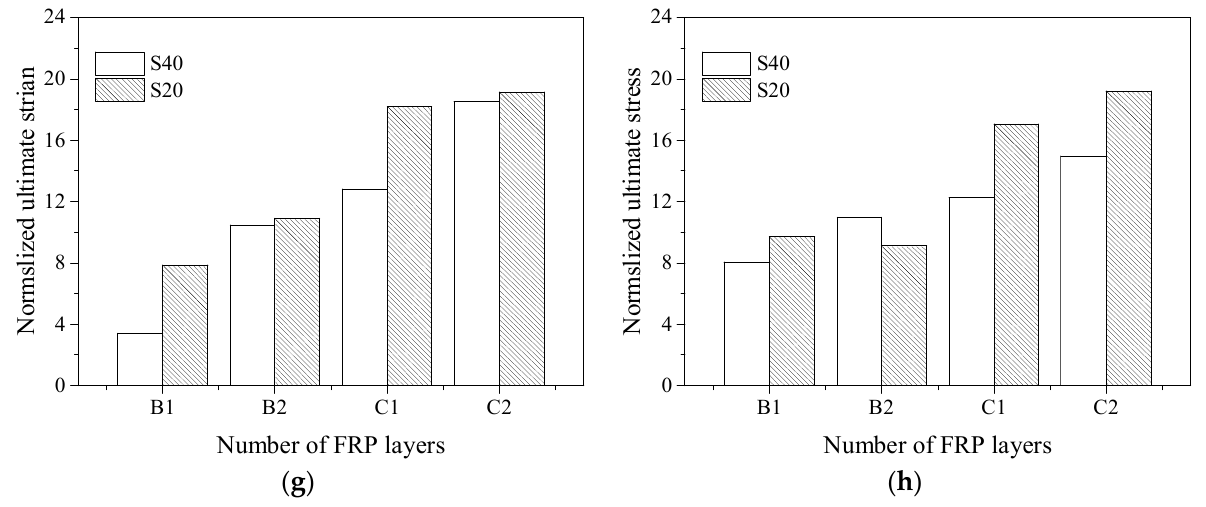
Figure 9. Effect of the stirrup spacing on the compressive behaviour of confined concrete columns: ( a ) peak stress (R25); ( b ) peak stress (R40); ( c ) peak strain (R25); ( d ) peak strain (R40); ( e ) ultimate stress (R25); ( f ) ultimate stress (R40); ( g ) ultimate strain (R20); ( h ) ultimate strain (R40).